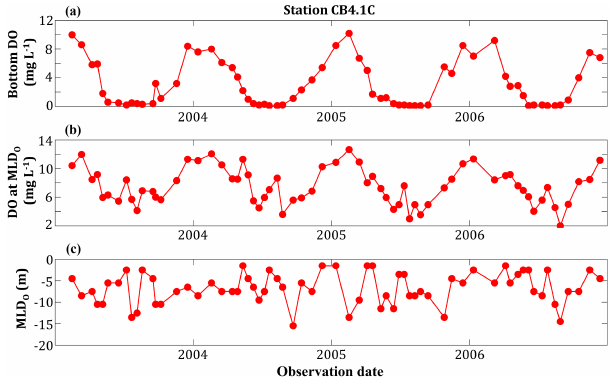
Figure 11. Time series of observations at station CB4.1C from 2003 to 2006 for (a) bottom dissolved oxygen, (b) dissolved oxygen at the MLD O , and (c) MLD O